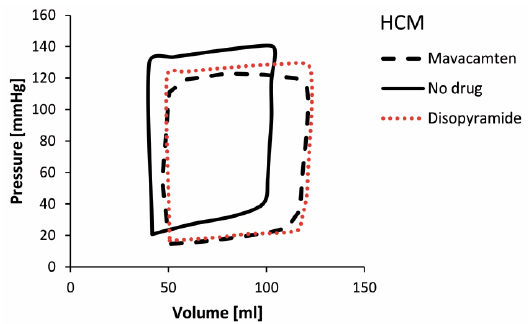
Figure 14. P-V diagrams for HCM at basic condition (without administered drug) and with using drugs Disopyramide and Mavacamten.